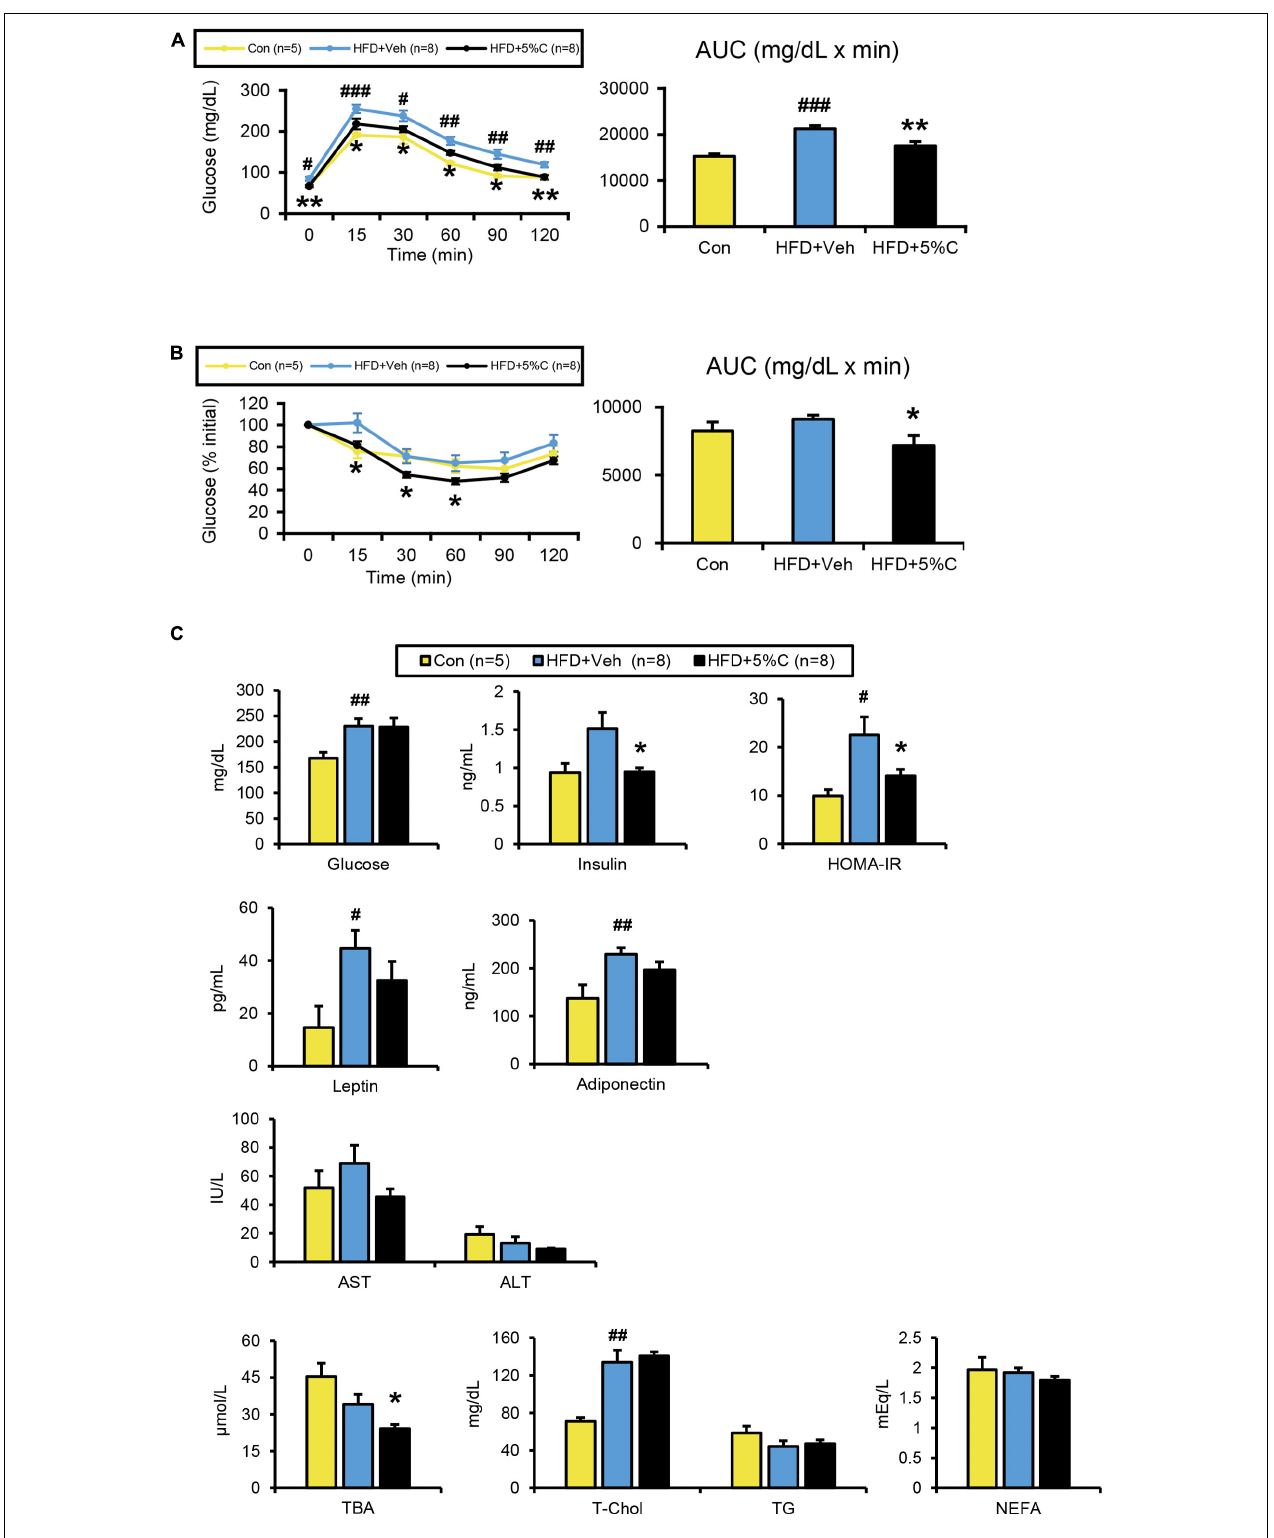
FIGURE 2 | Changes in metabolic parameters of mice treated with acidic activated charcoal. (A) GTT at 10 weeks of HFD feeding. (B) ITT at 12 weeks of HFD feeding. (C) Serum levels of glucose, insulin, HOMA-IR, leptin, high-molecular-weight adiponectin, AST, ALT, TBA, T-Chol, TG, and NEFA. Data are expressed as the mean ± SEM. Statistical analysis was performed using two-tailed Student’s t -tests. * P < 0.05 and ** P < 0.01 between the HFD + Veh group and the HFD + 5%C group. # P < 0.05, ## P < 0.01, and ### P < 0.001 between the HFD + Veh group and the Con group.